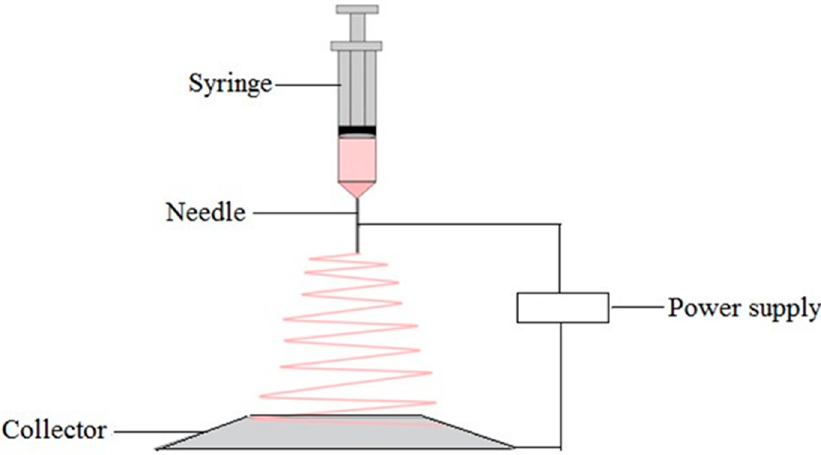
Figure 13. The schematic diagram of electrospinning technique.